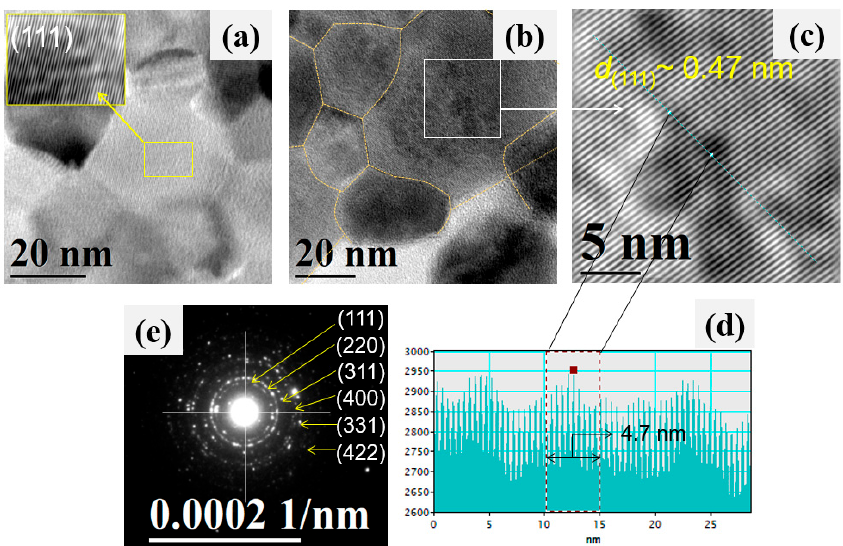
Figure 8 . Nanoparticle size distribution for the ZnAl 2 O 4 calcined at 300 °C. Figure 8. Nanoparticle size distribution for the ZnAl 2 O 4 calcined at 300 ◦ C.